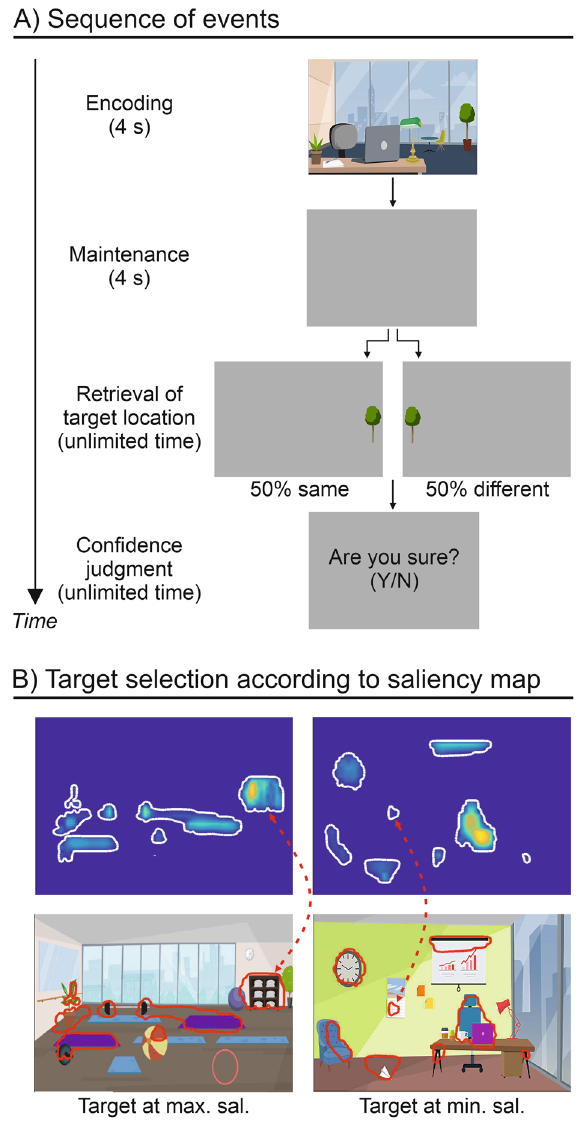
Figure 1. Experimental protocol. ( A ) Schematic diagram showing the sequence of events during one trial. The trial began with a cartoon scene presented for 4 s (encoding). A grey display was then shown for 4 s (maintenance). At retrieval, a single target object was presented either in the same or different location compared to the object’s location in the original picture. With unlimited time, participants had to judge the same versus different location of the target and then provide a confidence judgment requiring a yes/no response, as an index of meta-memory skills. ( B ) Examples of two cartoon scenes showing the selection of the target object related to either the point of maximal (left) or minimal salience (right) of the